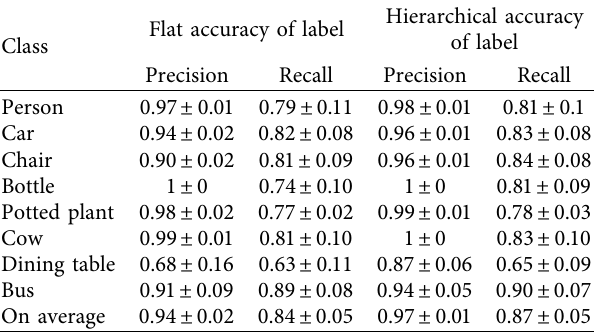
Table 7: Annotation accuracy of ground truth annotations for the selected images of the PASCAL 2007 dataset (the average values are computed for the twenty